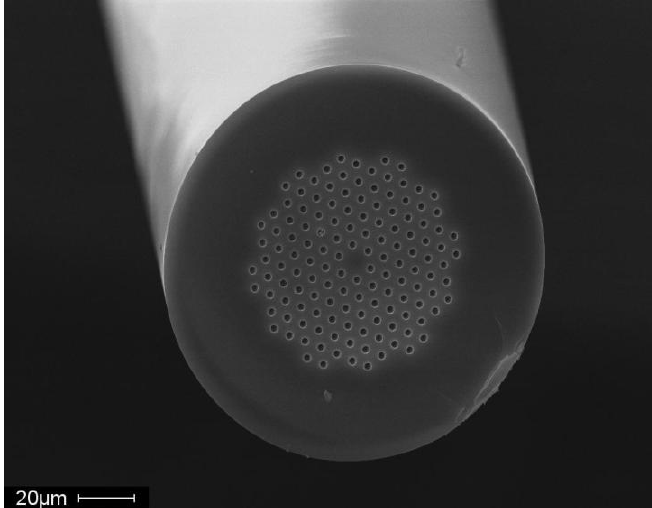
Figure 2. Microstructured quartz optical fiber cross-section SEM image taken at 30 keV. The fiber diameter is 125 microns with 138 air filled inclusions of 2.5 microns each. These inclusions become filled with